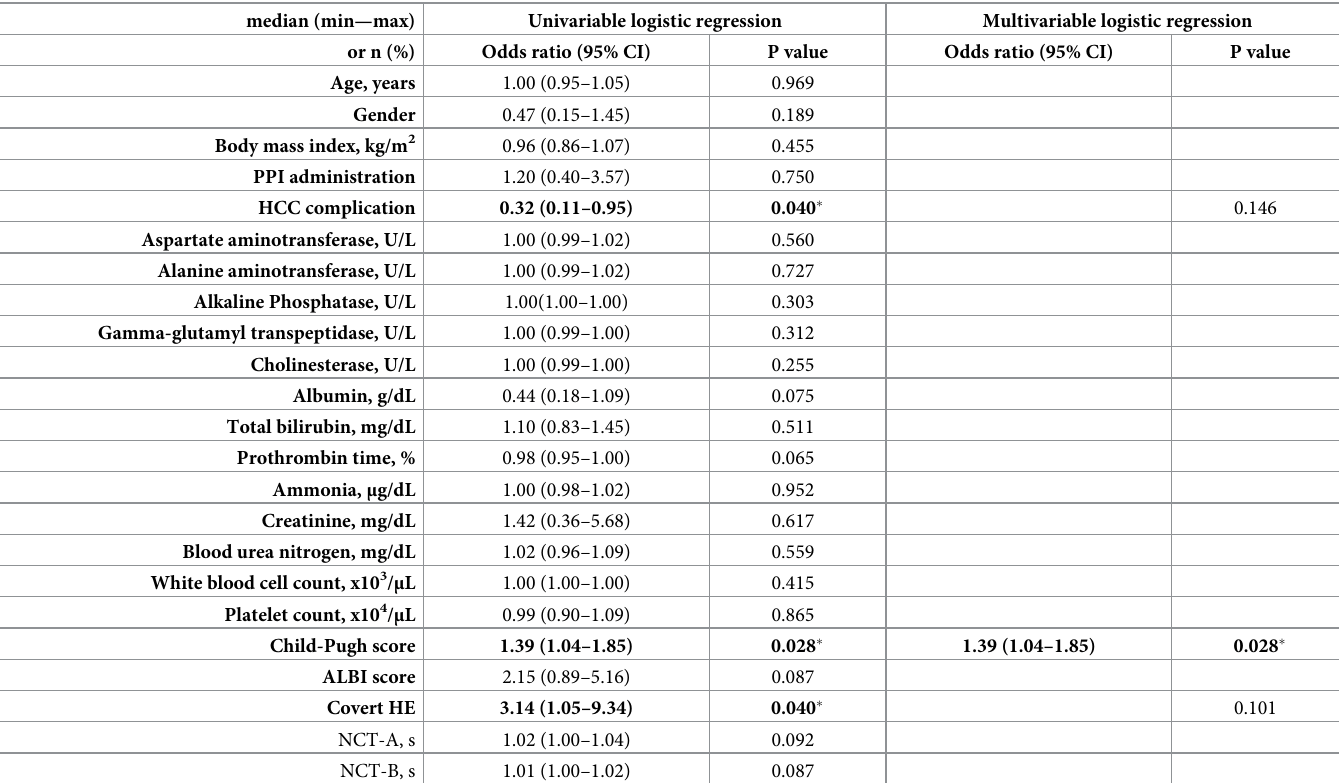
Table 3. Univariate and multivariate logistic analyses clustered by